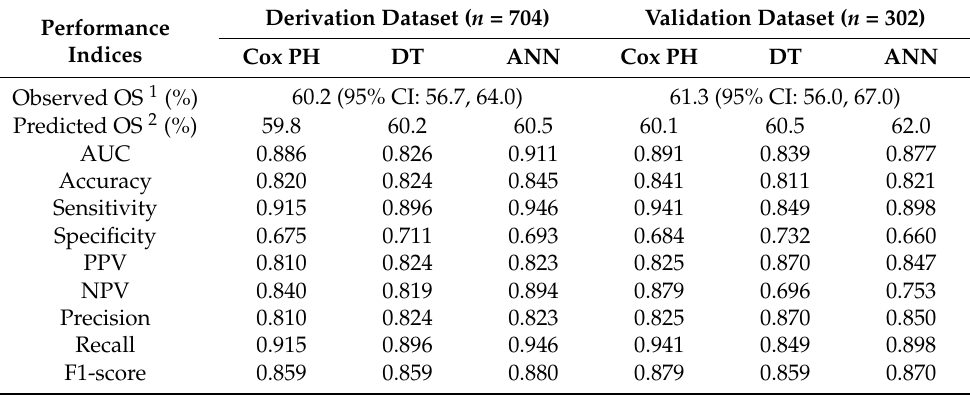
Table 2. Performance indices of the Cox proportional hazard (PH) regression models, decision tree (DT) analysis and artificial neural network (ANN) for predicting five-year survival of breast cancer patients.